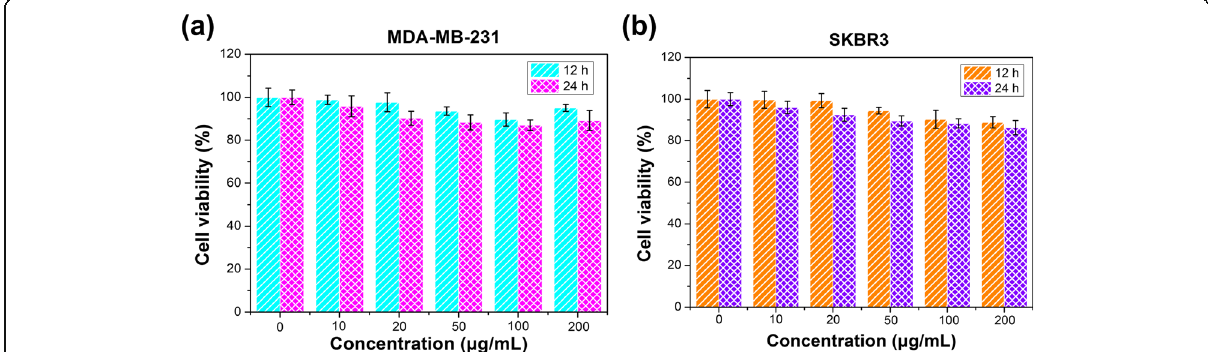
Fig. 5 Cell viabilities of a MDA-MB-231 and b SKBR3 cells at different dosages of Her2-GPH NPs (0, 10, 20, 50, 100, 200 μ g/mL) for 12 h and 24 h (data expressed as mean ± SD, n =